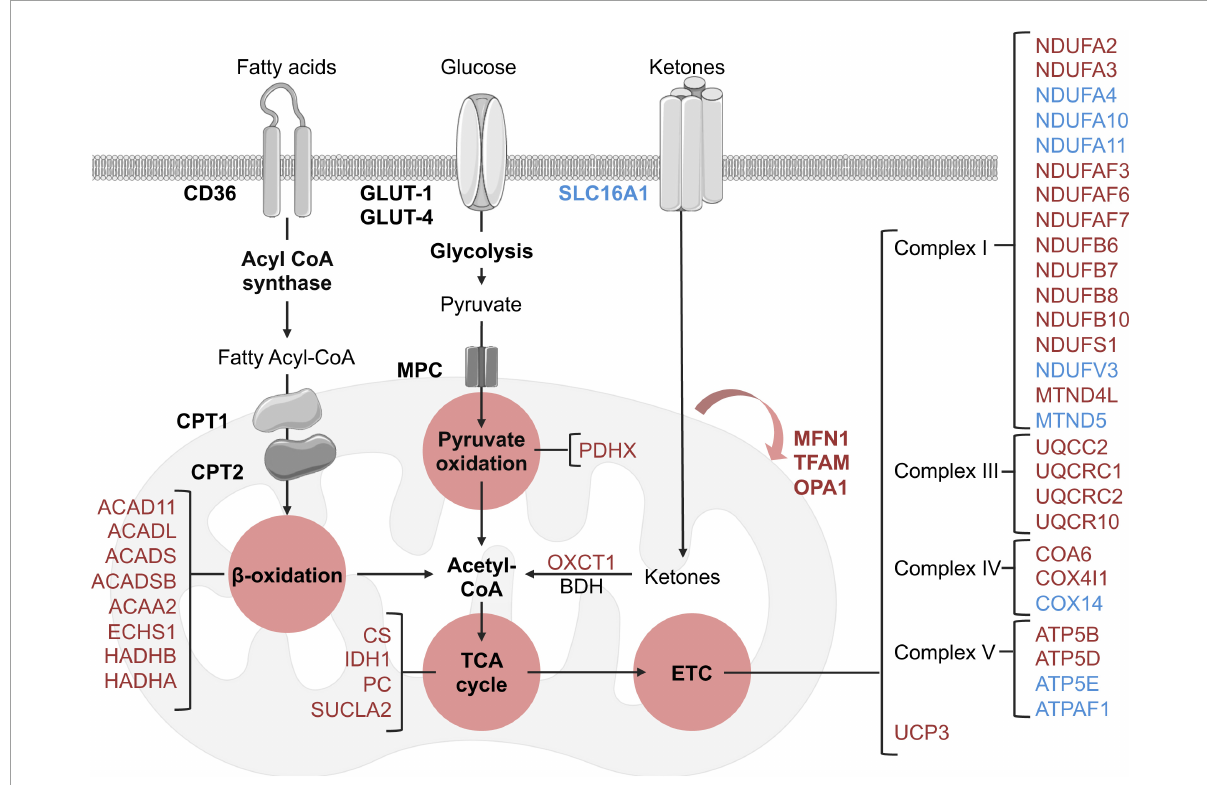
FIGURE3 Schematic overview of identified metabolic and mitochondrial related targets in HFpEF mice in the proteome dataset. Blue and red represent significant ( P < 0.05) up-regulation and down-regulation in HFpEF vs. Sham, respectively. Black targets are unchanged.